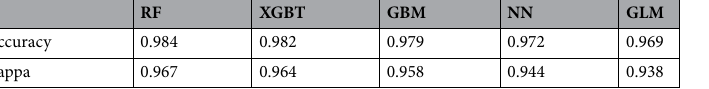
Table 7. Prediction accuracy and kappa value of each classification model (%). XGBT extreme gradient boosting tree model, GBM gradient boosting model, NN neural network model, GLM generalized linear model.